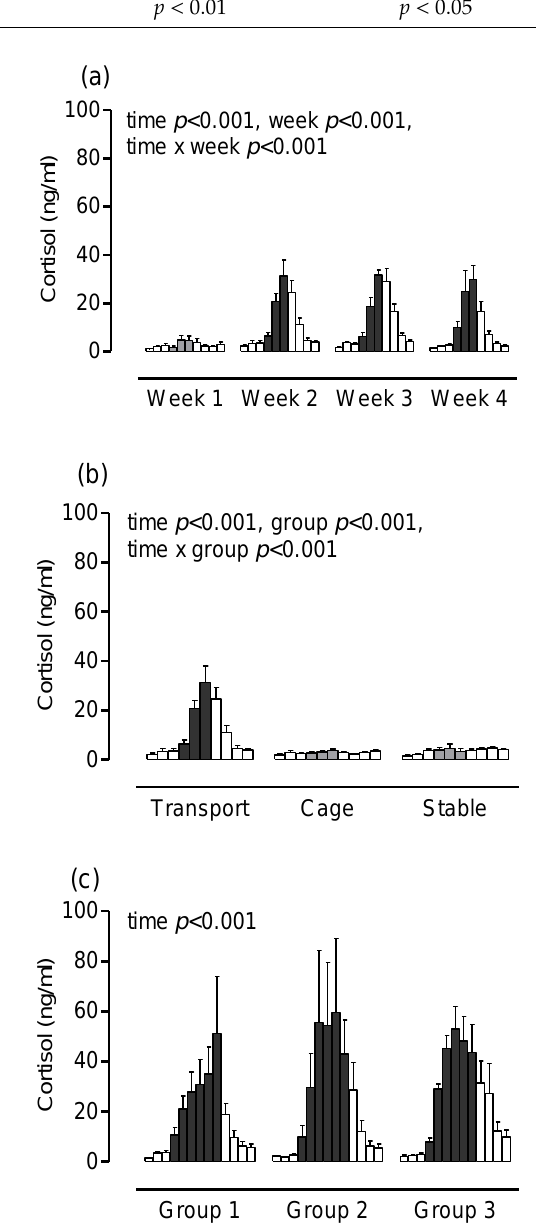
Figure 1. Concentration of cortisol in saliva ( a ) of the same dogs ( n = 6), either resting in their stable (week 1), or transported by road for one hour at one week intervals (weeks 2–4); ( b ) three groups of dogs (n = 6 each), either transported by road for one hour, placed in the transport cage in a stationary car or remaining in their stable; and ( c ) the same three groups of dogs transported by road for two hours, open bars = 60 min pre and 120 min post-transport or control phase time, black bars = transport time and grey bars = respective control time, values are means ± SEM, significant di ff erences are indicated in the